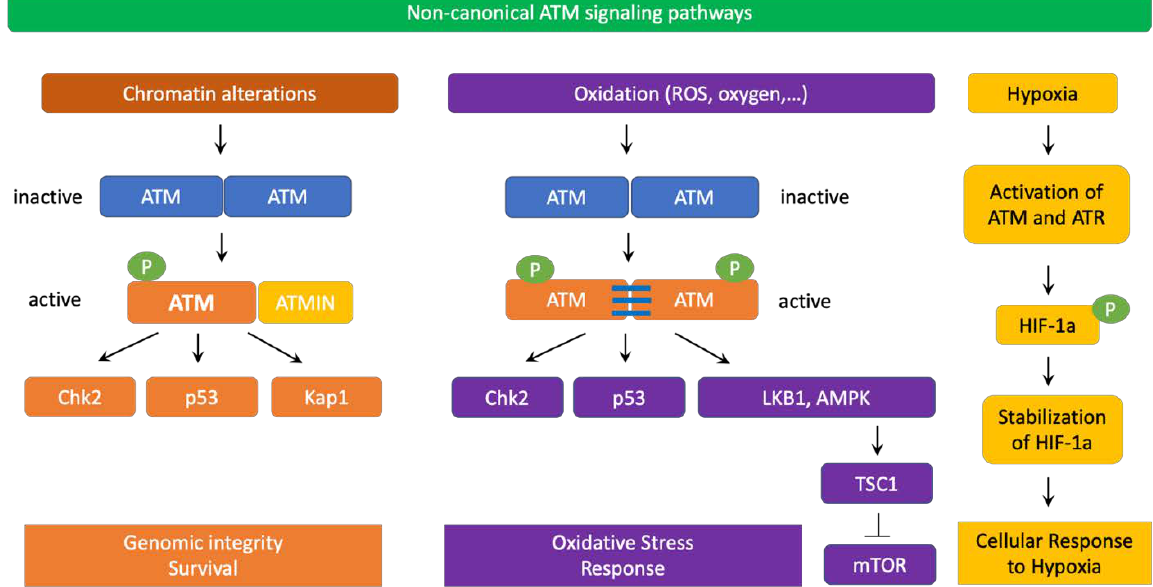
Figure 3. ATM non-canonical signaling pathways. Chromatin alterations induced by chloroquine or hypotonic stress could trigger ATM activation without requiring the MRN complex. The active monomer of ATM interacts with ATMIN (ATM interacting protein) to transduce downstream signaling to CHK2, p53, KAP1, and other substrates to promote genomic integrity and survival. ATM also serves as an important redox sensor. After being activated by ROS or oxidation, ATM homodimers establish disulfide bonds to maintain their dimer conformations. This activation process also does not require the MRN complex. Similar to active ATM monomers, induced ATM dimers are phosphorylated at Ser1981 but this posttranslational modification is not required for phosphorylation of downstream targets such as CHK2 at Thr68 or p53 at Ser18. Oxidation-activated ATM dimers then phosphorylate LKB1 and AMPK to turn on TSC2 and block mTOR signaling, thereby decreasing ROS levels. ATM can also be induced by severe hypoxia in a ROS-independent manner. In severe hypoxia, the function of ribonucleotide reductase is inhibited, causing the depletion of deoxynucleoside triphosphates (dNTPs) as well as replication stress. As a result, ATM and ATR are activated due to severe hypoxia. ATM and ATR then phosphorylate and stabilize HIF1α to enable cell survival under hypoxic conditions.